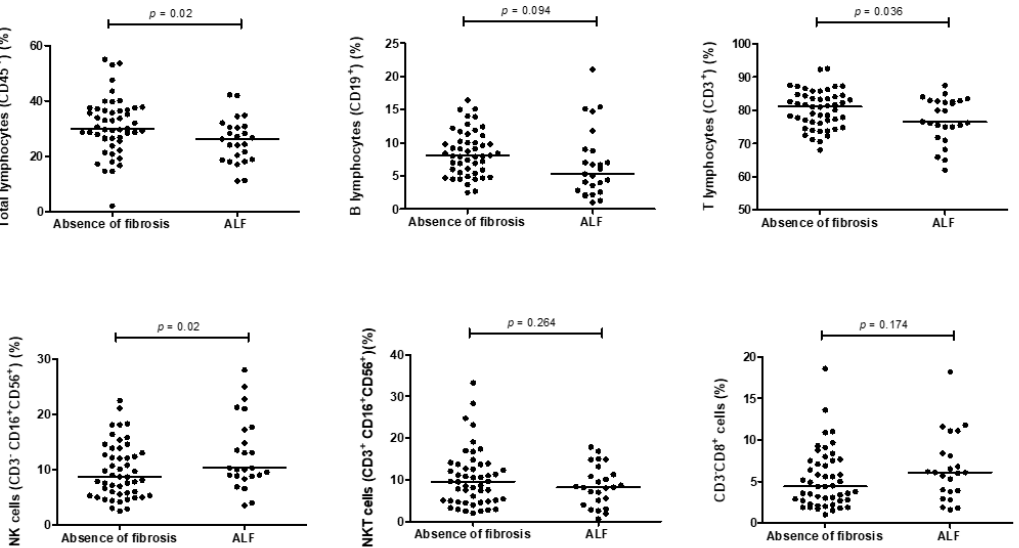
Figure 3. Proportion of lymphocyte subpopulations with respect to total lymphocytes and degree of liver fibrosis (LF).